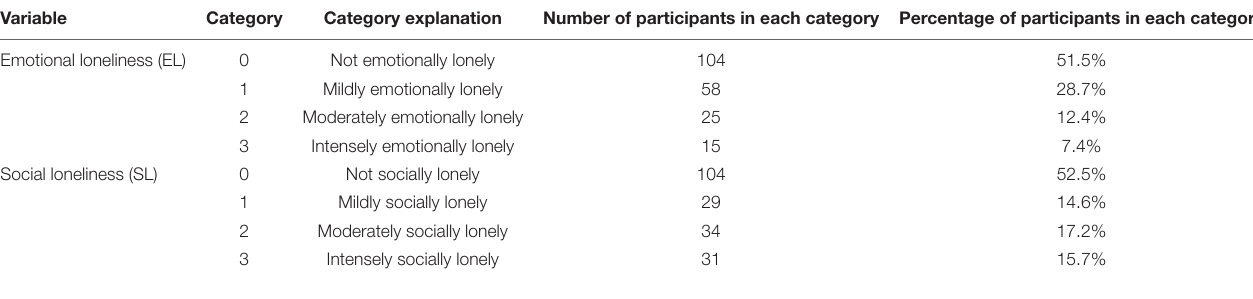
TABLE 5 | Nominal regression emotional loneliness (EL) and social loneliness (SL).